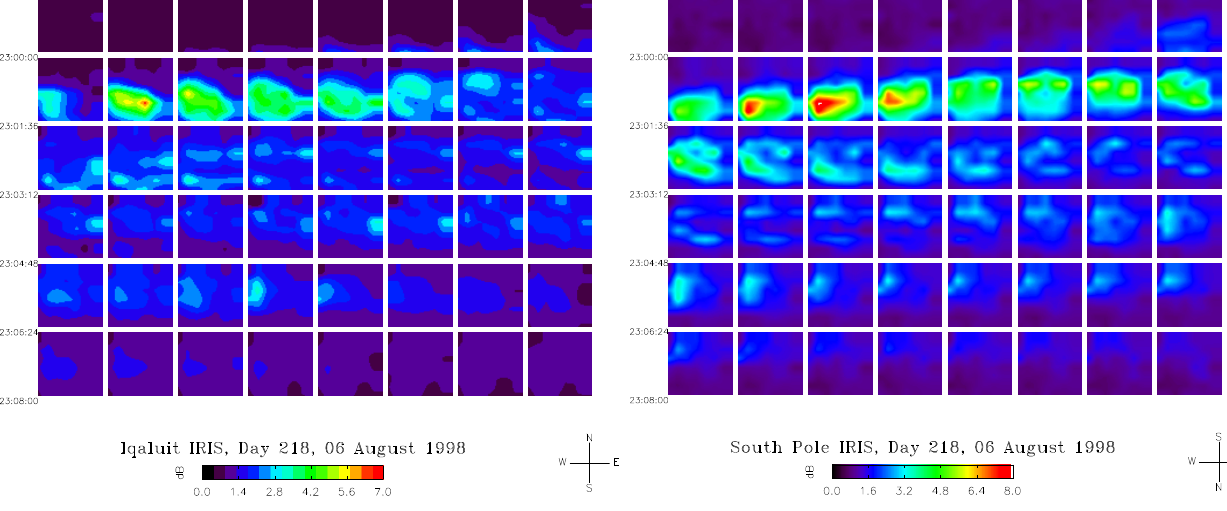
Fig. 8. Time series of absorption intensity images with 12 s time steps from the two conjugate riometers in Iqaluit (left) and the South Pole (right). The time interval covered is 23:00:00–23:09:24 UT on 6 August 1998. Poleward is up and eastward is to the right in both